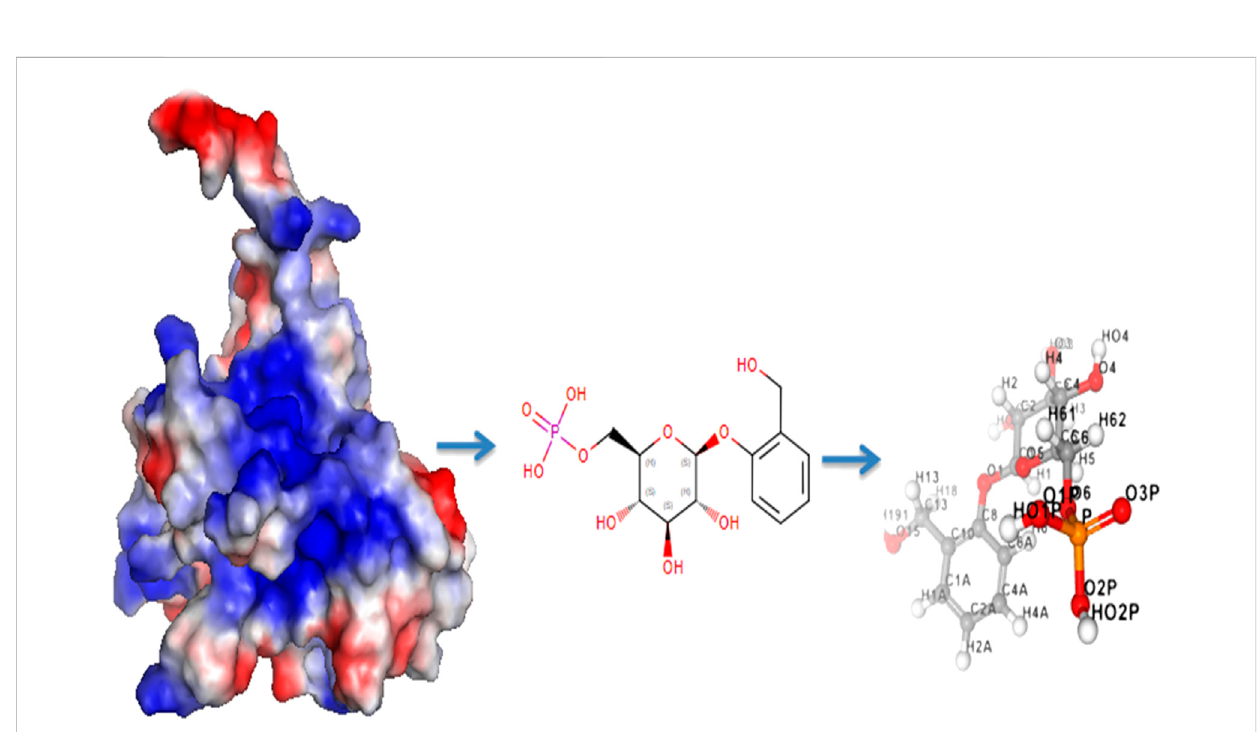
FIGURE 5 3D docked possess of leading